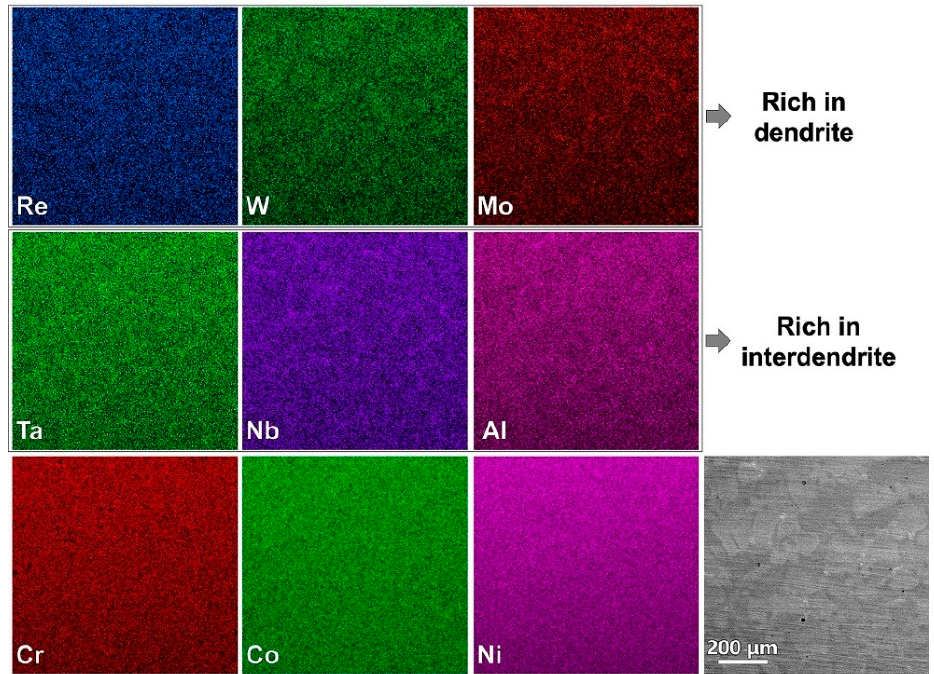
Figure 3. Energy dispersive spectroscopy (EDS) maps showing element distribution in an as-grown Ni-based single crystal superalloy. Refractory elements Re, W, and Mo segregate at dendrite arms, while Ta, Al, and Nb segregate at interdendritic regions.